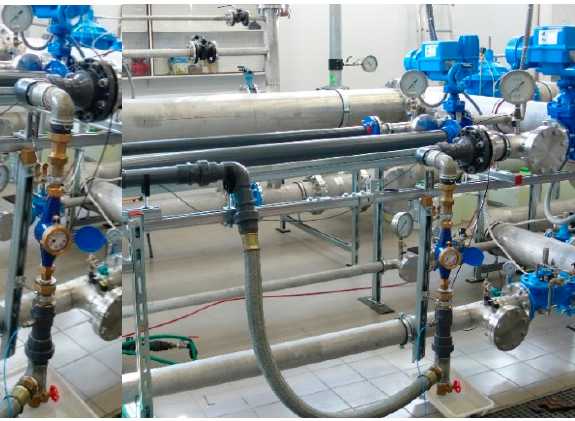
Figure 9. Water meter blocking laboratory test and detailed image of water meter test bench.